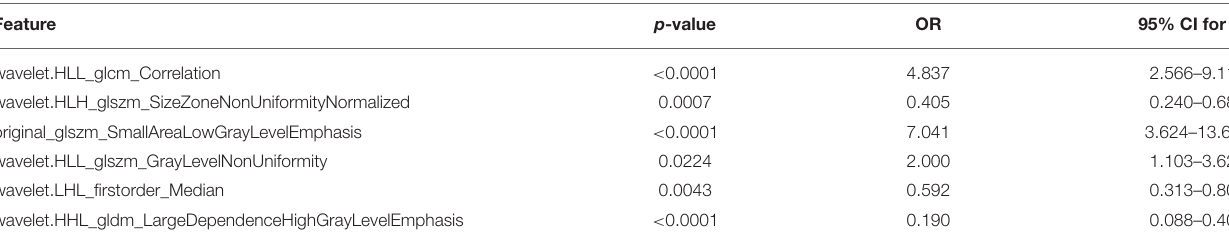
TABLE 2 | Six Radiomics features that were screened out to build model